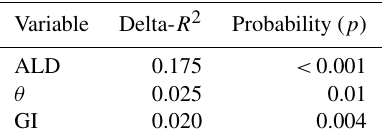
Table 3. Result of stepwise multiple linear regression with CH 4 flux as a dependent variable. The normality test failed, but signif- icance in all variables was confirmed with Wilcoxon signed-rank tests. ALD is active layer depth, θ is soil moisture and GI is the green index. Variable Delta- R 2 Probability ( p ) ALD 0.175 < 0.001 θ 0.025 0.01 GI 0.020